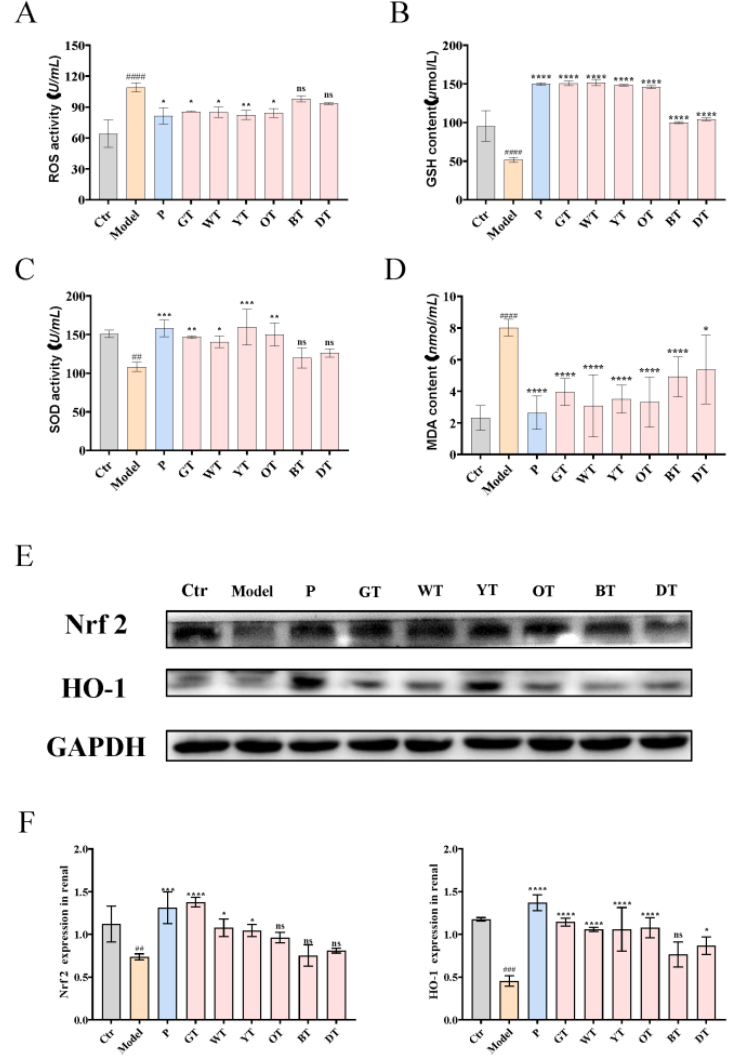
Figure 5. Mechanisms of TWEs in relieving renal oxidative stress. ( A ) Serum ROS activity. ( B ) Serum GSH levels. ( C ) Serum SOD levels. ( D ) Serum MDA activity. Representative immunoblots ( E ) im- ages of Nrf2 and HO-1 expression in the kidney. Quantification of Nrf2 and HO-1 expression by Western blotting ( F ). The data are expressed as mean ± SD. ## p <0.01, ### p < 0.001, #### p < 0.0001 were compared with the control, ns p > 0.1, * p < 0.1, ** p <0.01, *** p < 0.001, **** p < 0.0001 were compared with the model.